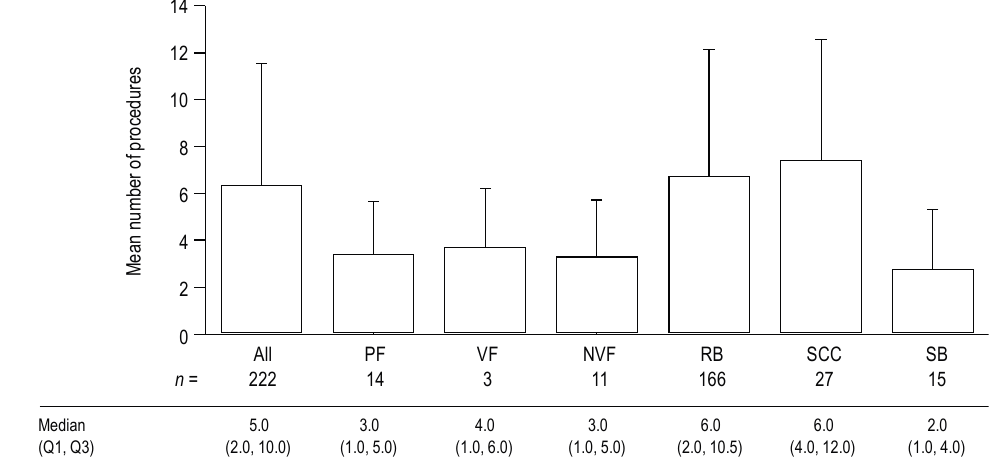
Figure 6. Mean number of procedures for each type of SRE and for all types of SRE combined. Data shown as mean (+standard deviation) number of procedures per